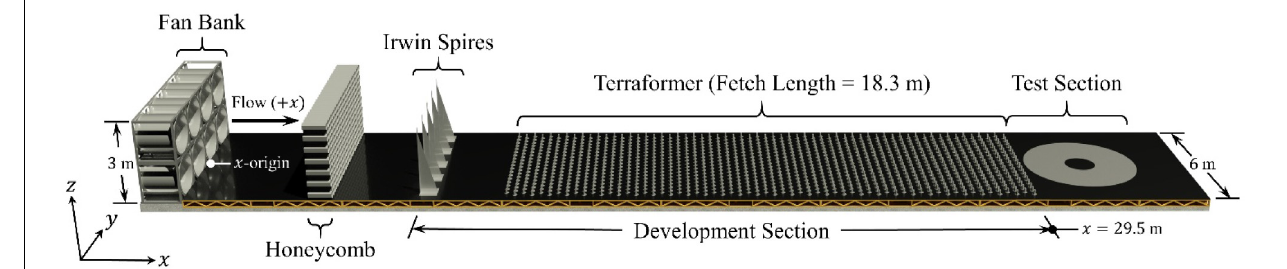
FIGURE 1 | Diagram of the BLWT at the UF